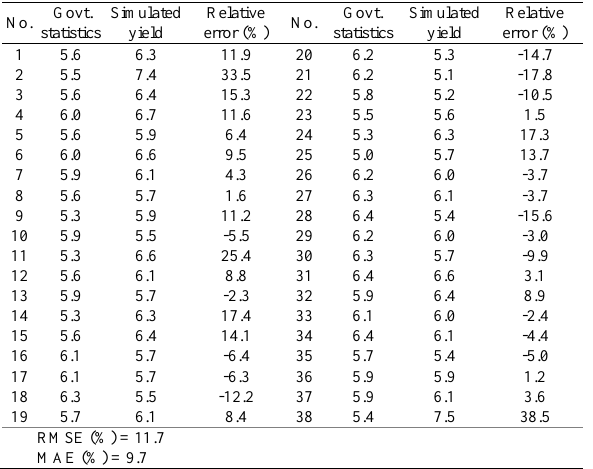
Table 1. Relative error between the simulated rice yield and the government’s yield statistics for the first crop in 2014.